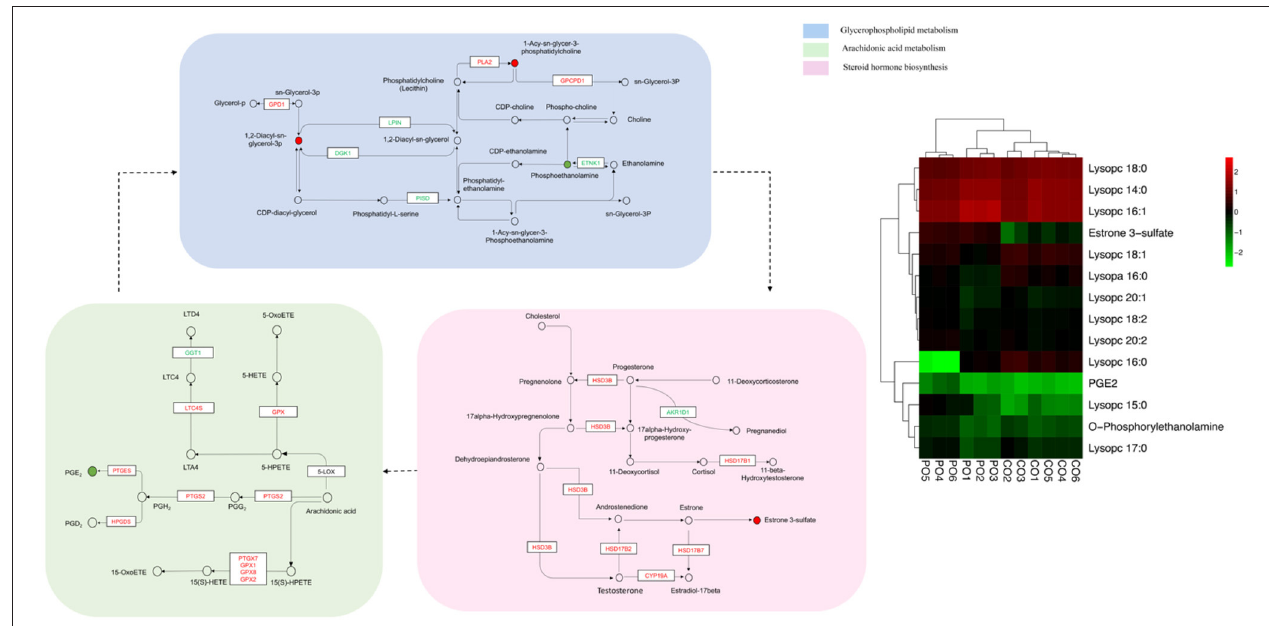
FIGURE 5 | Constructed three key pathways that integrated relative metabolite contents and gene expression. Different colors were used to represent down-regulated DEGs (blue), up-regulated DEGs (red). The heatmaps are drawn according to the metabolomics data. Columns and rows in the heatmap represent groups and metabolites, respectively. The color scale indicates fold changes (Log10) in gene